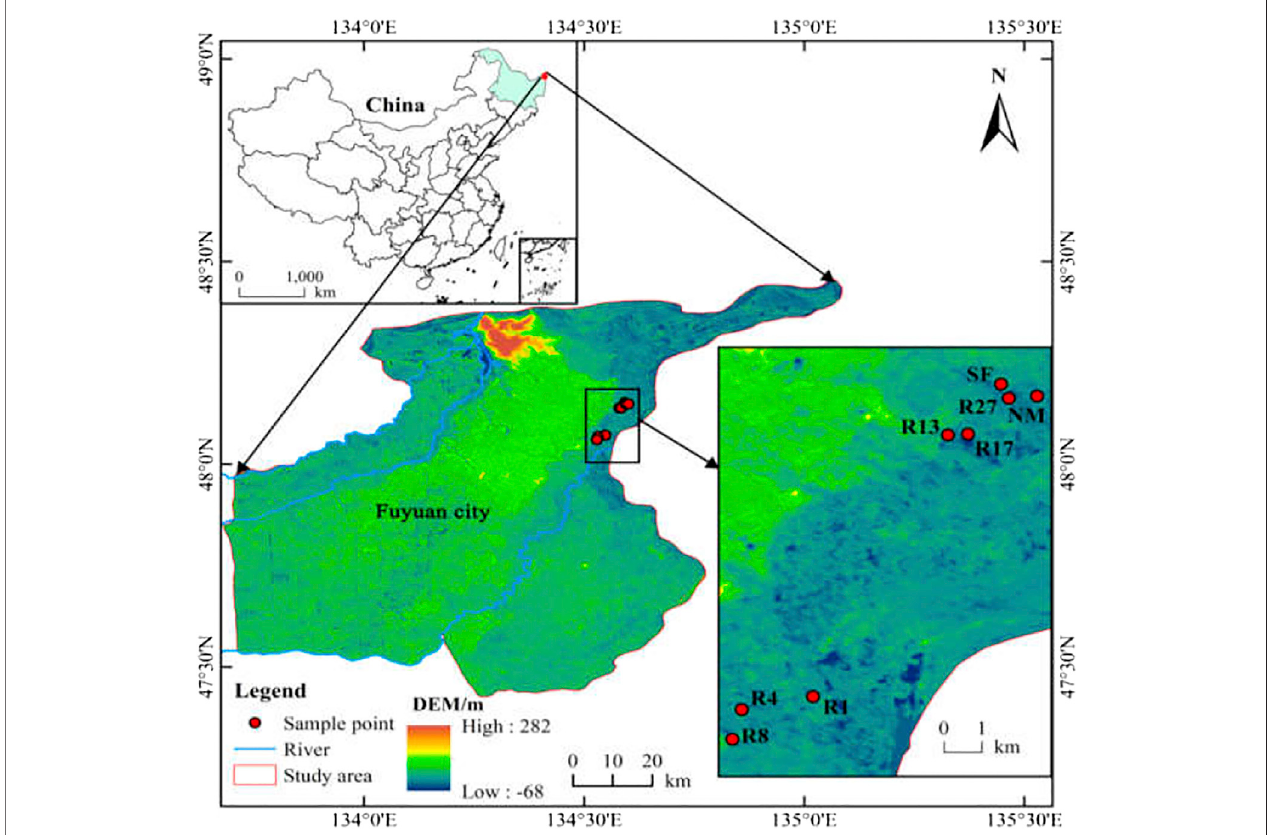
FIGURE1| LocationofthesamplingsitesinSanjiangPlain,NortheastChina.SF,soybean fi eld;R1,R4,R8,R13,R17,andR27,restoredsitesafter1,4,8,13,17, and 27 years of farmland abandonment; NM, natural marsh.